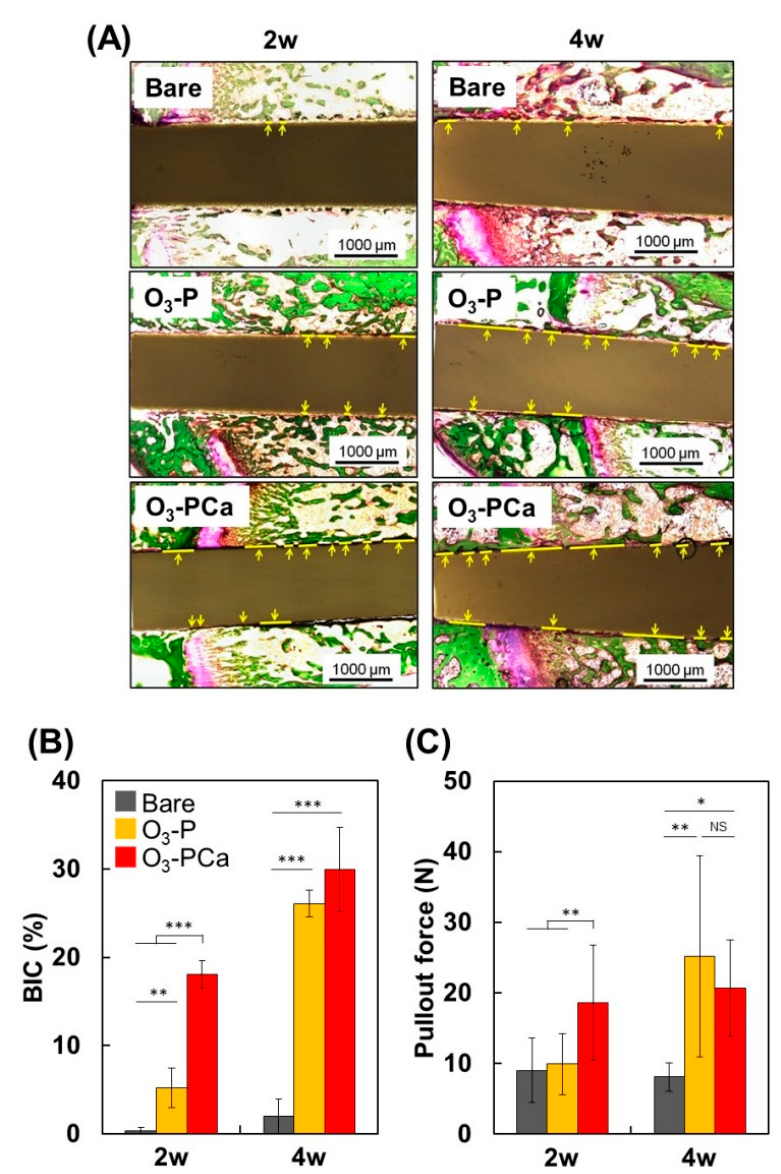
Figure 6. Osseointegration capability of samples in a rat femur implantation model. ( A ) Histological images of new bone formation and osseointegration at two- and four weeks post-implantation. Sections were stained by the Villanueva-Goldner stain. Yellow lines indicate bone tissue directly in contact with implants. Scale bars are 1000 µ m. ( B ) Bone-to-implant contact ratio (BIC) ( n = 3), and ( C ) bond strength between bone and implant (pullout force) ( n = 6). Data are mean ± standard derivation (* p < 0.05, ** p < 0.01, *** p < 0.001, NS: not significant). Bare: untreated PEEK, O 3 -P: phosphate-immobilized PEEK, O 3 -PCa: phosphate and calcium co-immobilized PEEK.